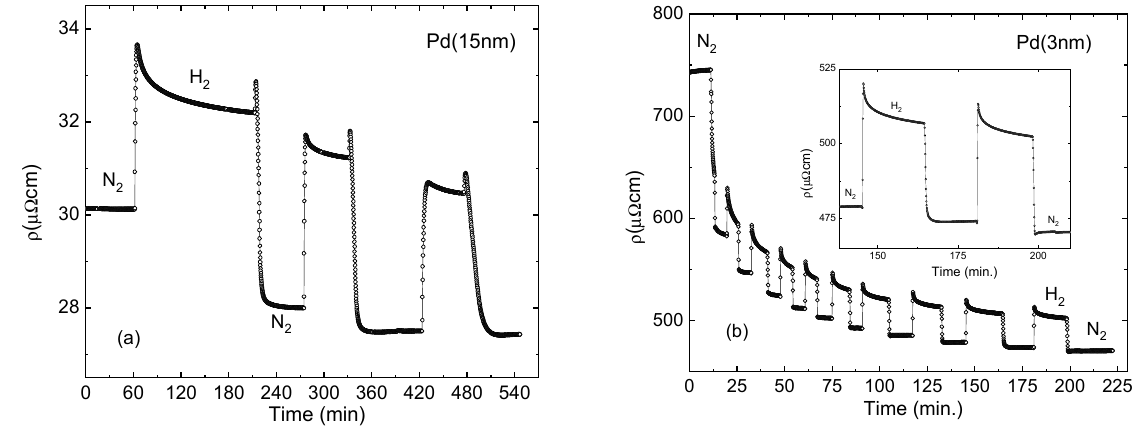
Figure 4. Resistivity response of 15 nm ( a ) and 3 nm ( b ) thick Pd samples to the sequences of hydrogenation and dehydrogenation cycles (sequential exposure to 1 atm 4% H 2 /N 2 gaseous mixture followed by N 2 ). The sharp increase in resistance on hydrogen loading and the respective drop on hydrogen removal are due to the hydrogen scattering.